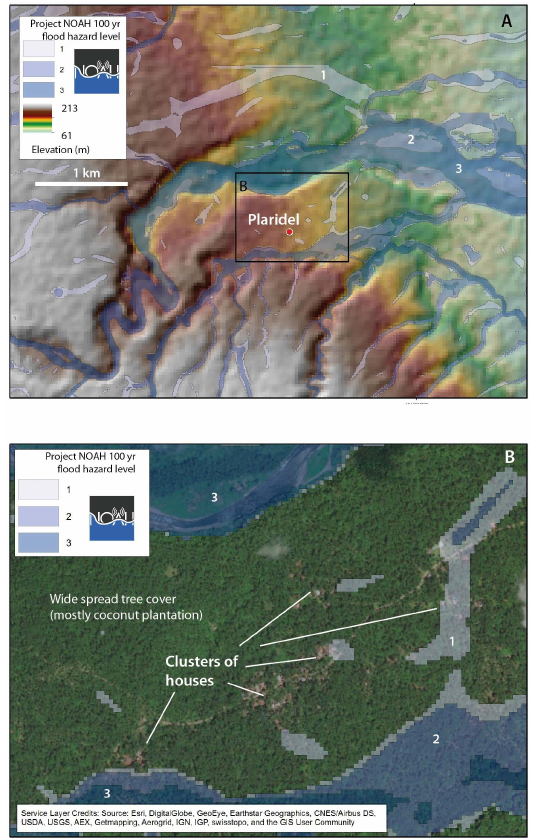
Figure 7. ( A ) Plaridel sits on an elevated terrace, which has developed during the Holocene as the Binahaan river to the north and Panda river to the south have incised to lower levels. Much of the terrace lies above modelled flood levels. Elevation model derived from NASA SRTM [60]. ( B ) Satellite image of Plaridel showing spread out housing and dense tree cover. Base map provided by Environmental Systems Research Institute (ESRI). The flood hazard levels in both images ( A , B ) are taken from the Nationwide Operational Assessment of Hazards (Project NOAH) 100-year return